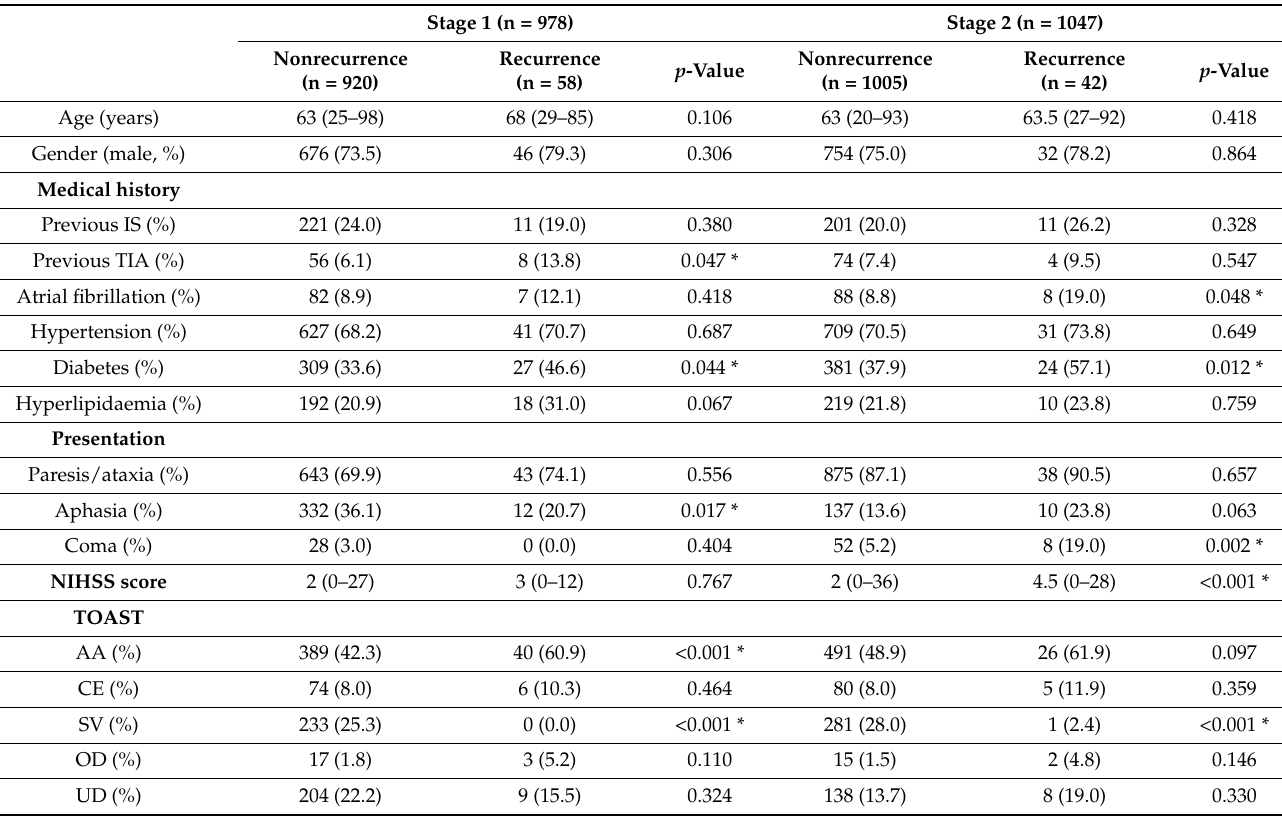
Table 2. Comparison of the demographic features, clinical characteristics and medical care between the recurrence and nonrecurrence groups in different